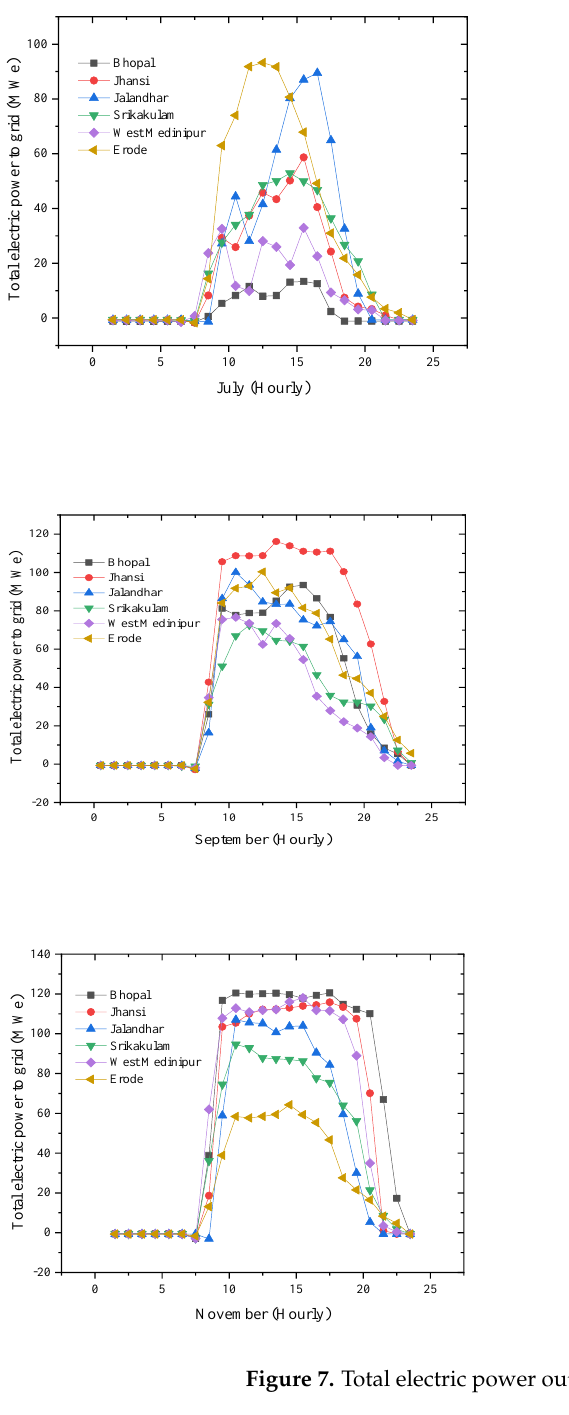
Figure 7. Total electric power output to grid (wet-cooled) for six potential sites.